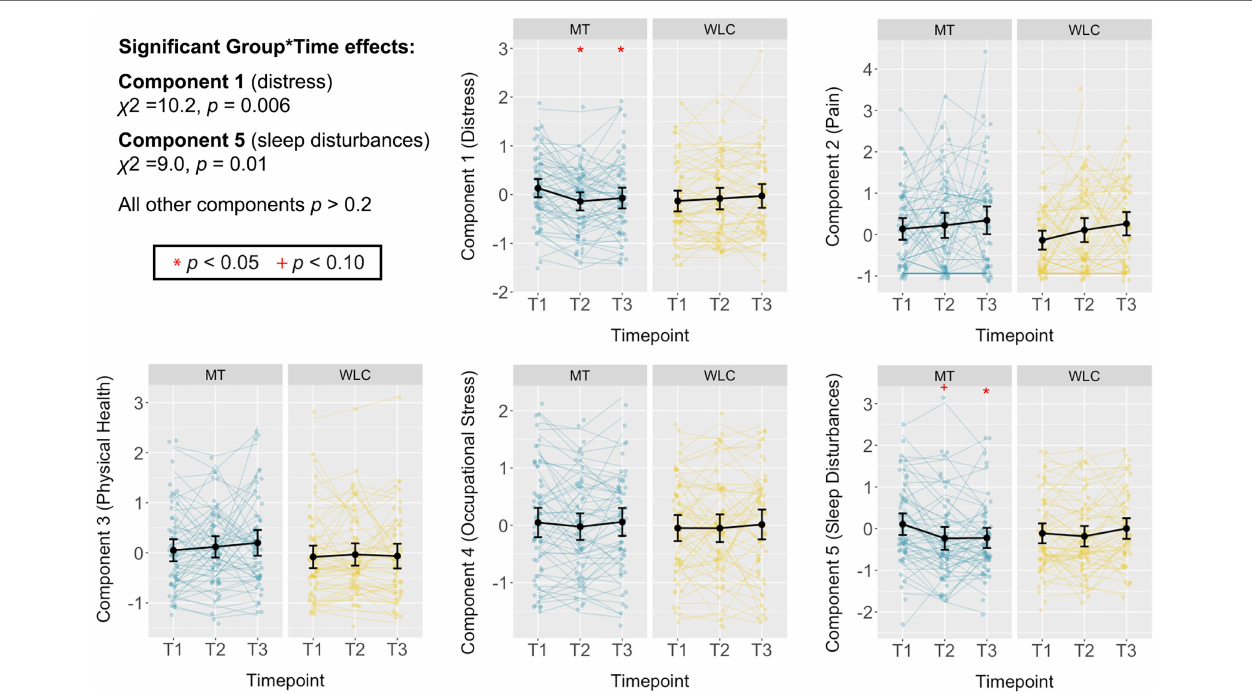
FIGURE 2 | Effects of mindfulness training on self-reported, stress-relevant health outcomes. Standardized scores for each self-report domain identified through principal component analysis (PCA), plotted separately for mindfulness training (MT), and waitlist control (WLC) groups at baseline (T1), post-training (T2), and 3-month follow-up (T3). Relative to WLC, participants in the MT group had a significant reduction in self-report outcomes related to psychological distress and mental health symptoms (Component 1; χ 2 = 10.2, p = 0.006), with group differences evident at T2 and T3 when controlling for scores at T1. A significant Group*Time interaction was also seen for sleep disruptions (Component 5; χ 2 = 9.0, p = 0.01), although this difference was significant at T3 only. No other intervention effects were seen ( p s > 0.2). Summary statistics are within-group means with 95%